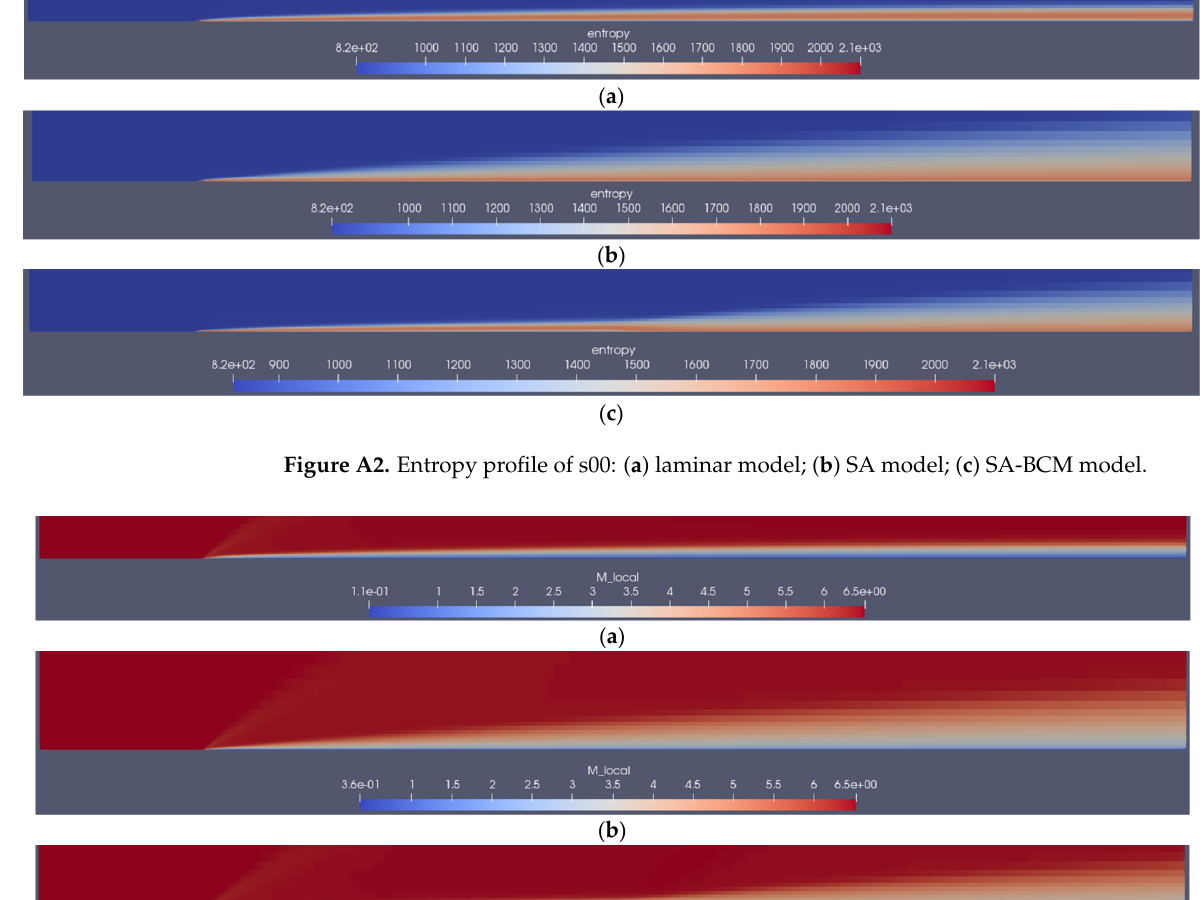
Figure A1. Grid convergence study of cell ratio ‘a’ in SA model.